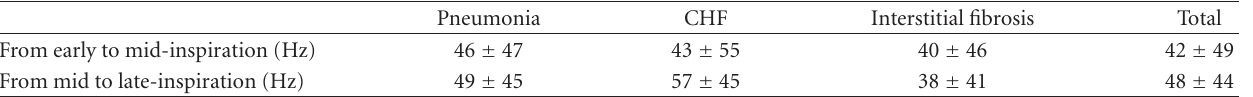
Table 3: An average change in crackle pitch among the patients whose crackle pitch increased during inspiration.